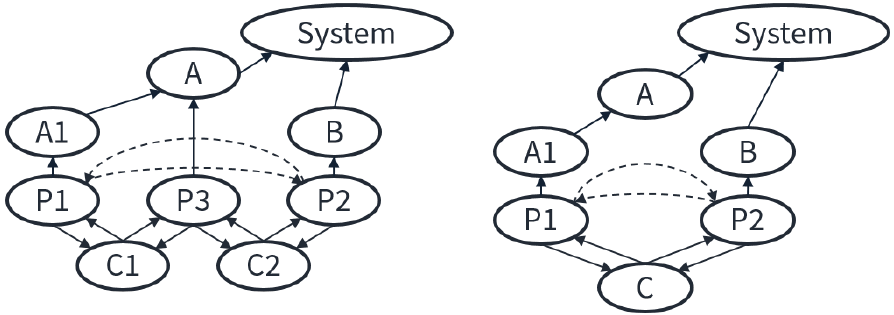
Figure 21. Diagrams of the categories for the block diagrams from Figure